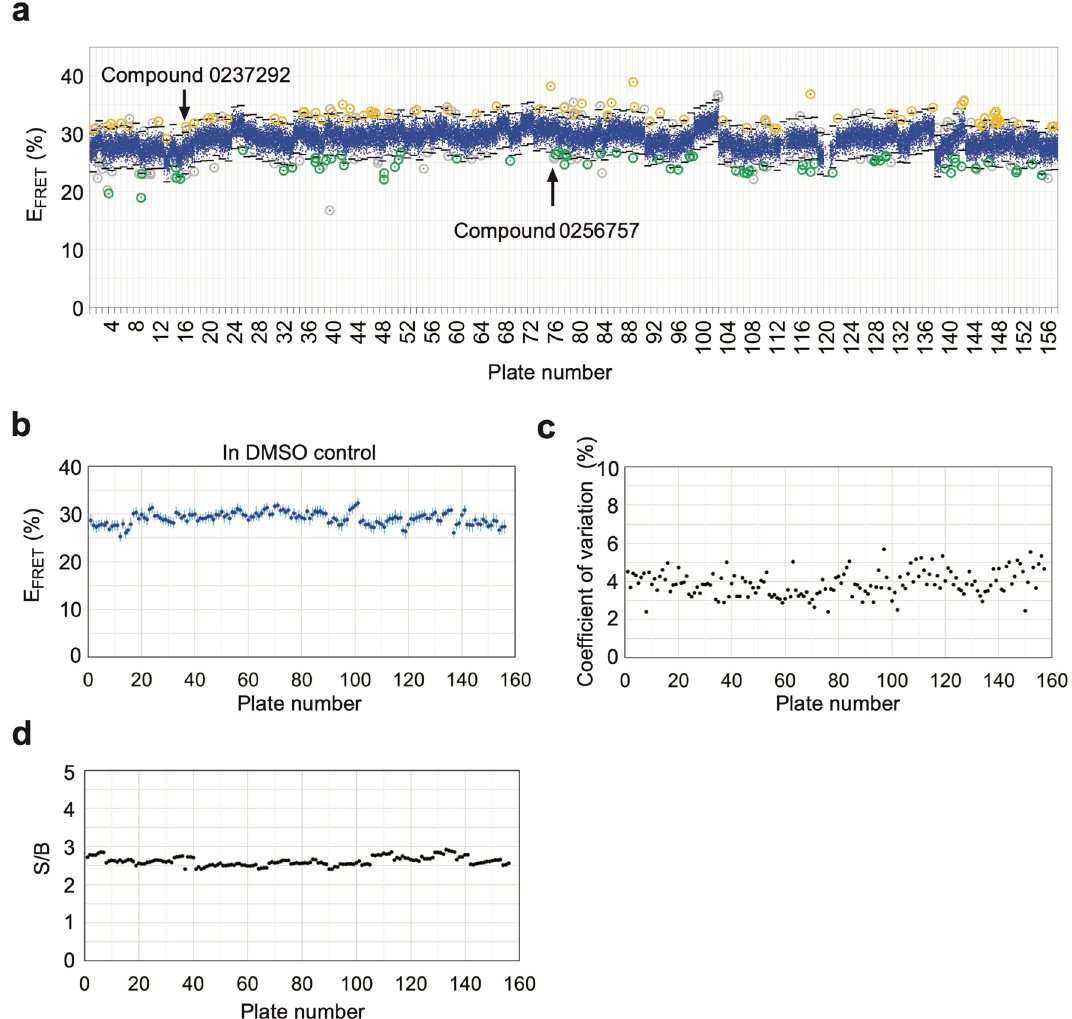
Figure 7. HTS results. ( a ) Raw FRET results for A455E NBD1 (acceptor and truncation at residues 487 and 654) screen using a 50,240 small molecule diversified library. Blue dots represent each averaged E FRET value calculated based on two D and D + A pairs, and measured for compounds from 157 plates (1,536-well plate format, 600 beads/well, 320 compounds/plate). Black lines show ± 3SD for each plate. 133 primary hit compounds are indicated in orange circles (increase in FRET) or green circles (decrease in FRET) (0.26% hit ratio). Gray circles indicate averaged FRET values outside of ± 3SD but either or both single FRET values inside of ± 1.75SD. ( b ) Graph showing E FRET values (mean ± SD, n = 32) of DMSO control for each plate. ( c – e ) Black dots represent coefficient of variation (SD/mean) of E FRET values ( c ), or signal to background (mean D signal/ mean background) ( d ) for each